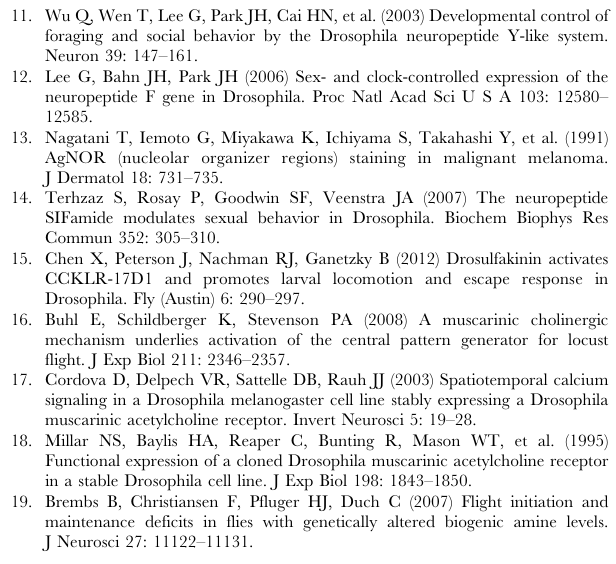
expression of either AcGq (green) or dSTIM + (blue). Pan-neuronal GAL4 controls (grey), with AcGq (green) and dSTIM + (blue) showed normal flight. Open circles within the bars represent percentage flight times for individual flies. Where multiple animals gave the same flight time, the circles are overlapping. Percentage flight time was obtained by measuring flight in single flight assays from 20 flies of each genotype. (**P , 0.01, *P , 0.05, obtained by one way ANOVA tests, where the rescues were compared to pan-neuronal knockdown of the respective GPCR). Figure S3 Quantification of GPCR gene transcripts in larval brains after pan-neuronal expression of GPCR specific RNAi. The Ct values for each gene (indicated by individual CG numbers) were normalized to the level of a housekeeping gene ( rp49 ) in control RNA from CS larvae of an equivalent developmental stage. The Y-axis represents log2 fold changes calculated by the DD Ct method. Each value is the mean 6 SEM of three independent experiments, obtained from three independent RNA samples. RNA was extracted from larval brains expressing a GPCR RNAi that gave a flight deficit and from an RNAi strain for the same GPCR, in which the flight deficit was not observed. Gene expression was significantly reduced for the RNAi strains that gave a flight defect when compared to the expression of that gene in the pan-neuronal GAL4 control (*P , 0.05, **P , 0.005; Student’s t test). Expression level of a representative GPCR, as described in materials and methods, is shown in the first bar. Normal levels of gene expression were observed in the RNAi strains that did not give any flight defect. Figure S4 Expression pattern of PdfR(B)GAL4 and PdfR(A)GAL4 in larval brain, adult brain and thoracic ganglion. Expression of PdfR using PdfR(B)GAL4 (A) and PdfR(A)GAL4 (B) (green:antiGFP) in 3 rd instar larval brain. C) Level of expression of GFP in protein extracts of adult brains plus thoracic ganglia was assessed by western blots. The strength of expression of both GAL4 strains was similar. D) Schematic of adult brain showing regions of interest: mNSC: medial neurosecretory cells, VLP: ventrolateral protocer- ebrum, AMMC: antennal mechanosensory and motor complex, SOG: subesophageal ganglion, T1: thoracic region 1, T2: thoracic region 2, T3: thoracic region 3, Ab: abdominal region. E, F)